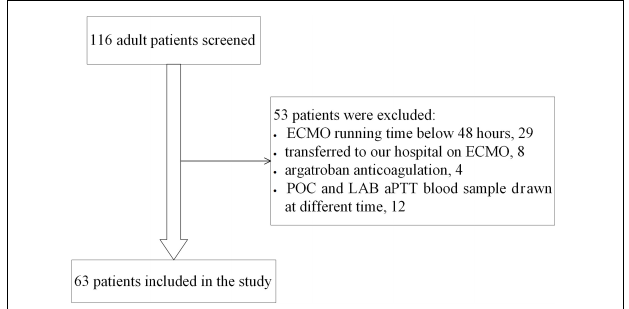
FIGURE 1 | Flowchart of patient